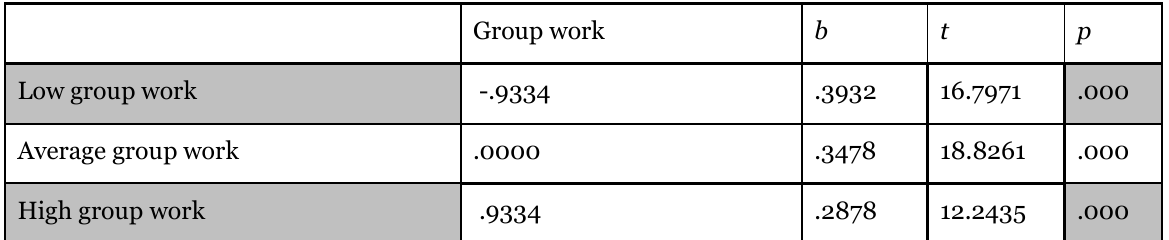
Centered Effects for Intrinsic Goal Orientation on Germane Load at Each Level of Group